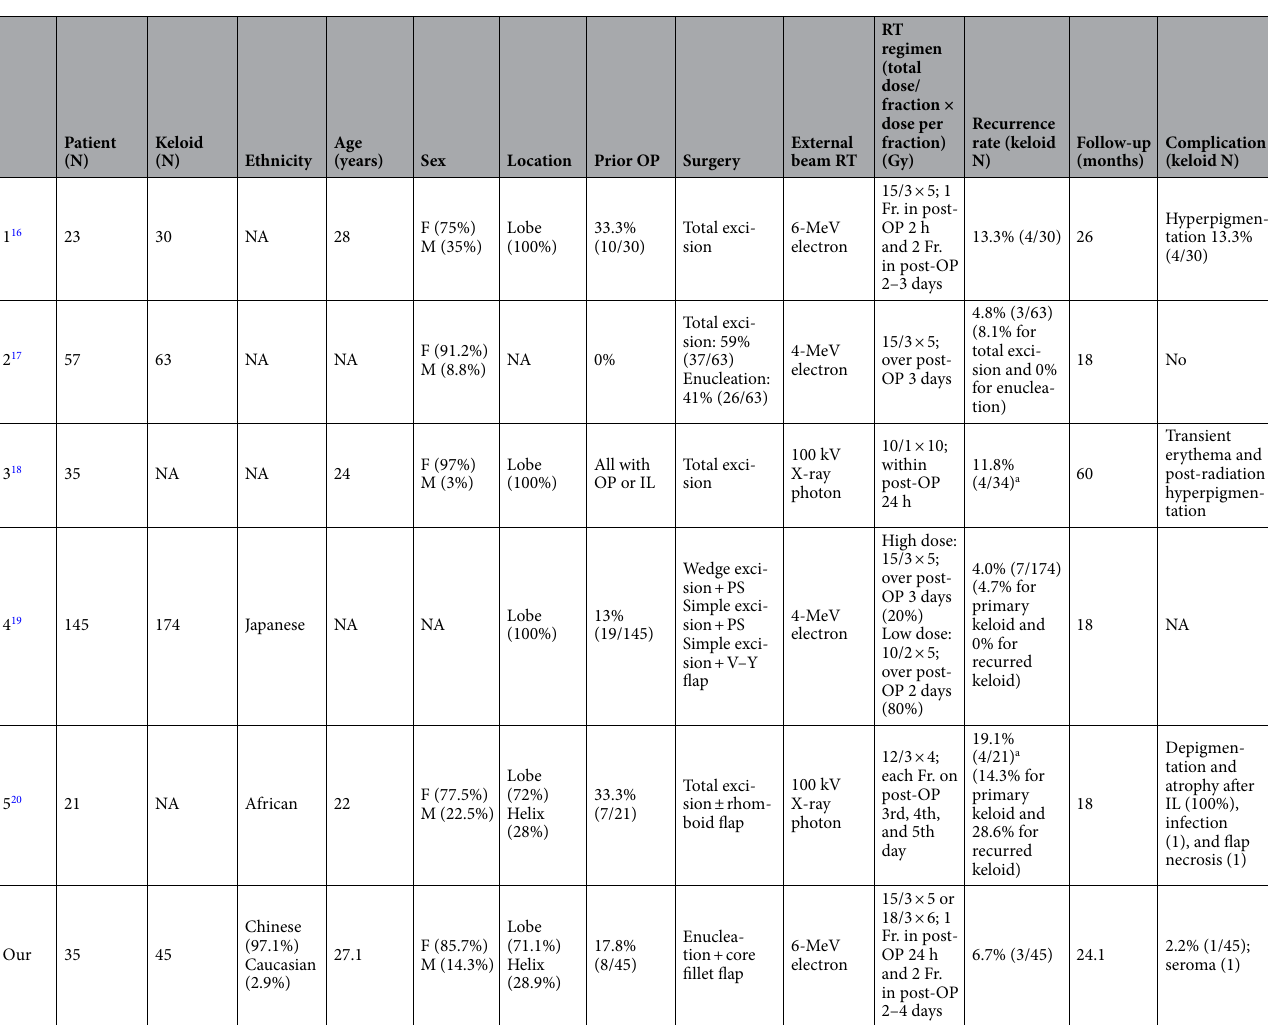
Table 5. Comparison with previous literatures adopting surgical excision with postoperative radiation therapy. a Number of patients. F female, Fr. Fraction, h hour, IL intralesional corticosteroid injection, M male, N number, NA not available, OP operation, PS primary suture, RT radiation